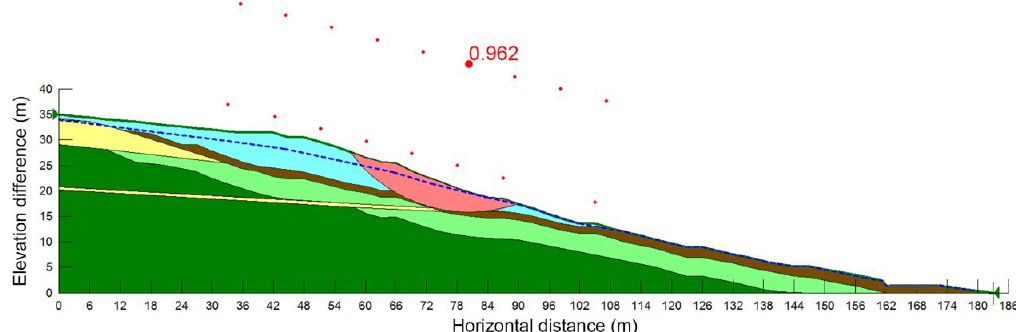
Figure 10. Area unstable (pink) considering the marls embankment with shear strength parameters defined in W4. Blue dashed line represents water as defined in W4. Blue dashed line represents water table.